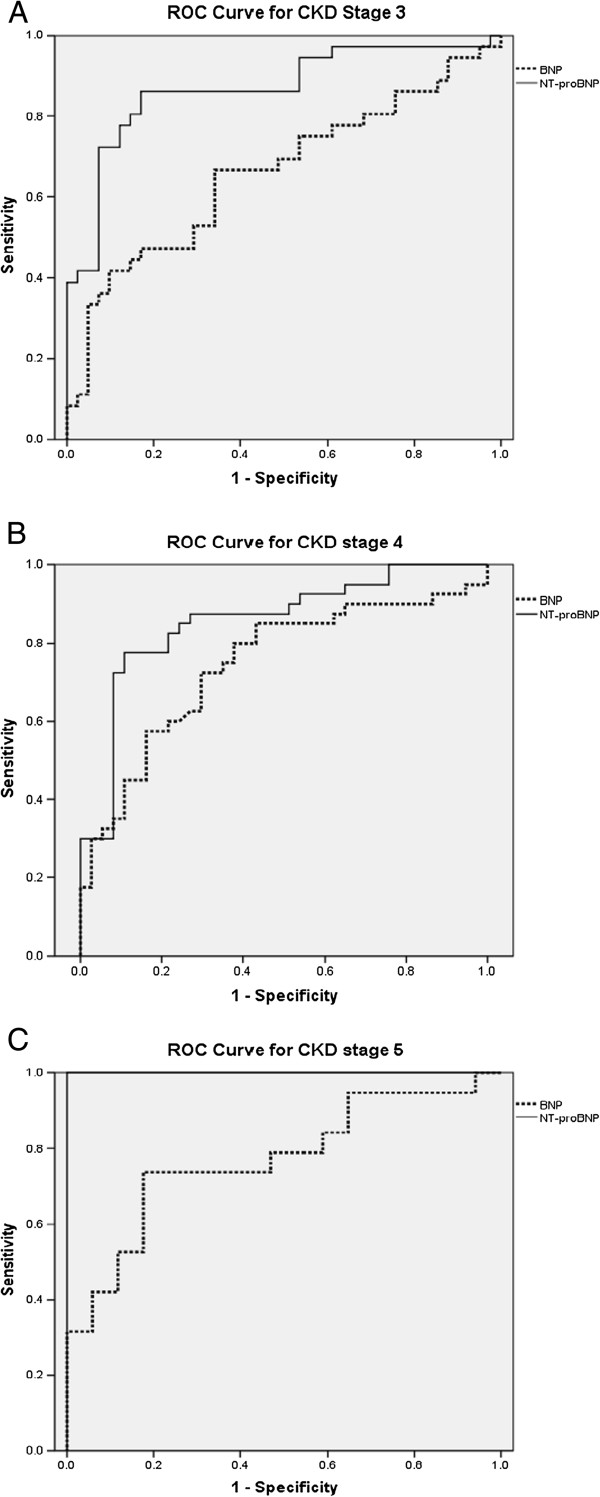
Receiver-operating characteristic (ROC) curves of BNP and NT-proBNP according to chronic kidney disease (CKD) staging. (A) For CKD stage 3 the area under the curve (AUC) for BNP and NT-proBNP was 0.66 and 0.88 respectively. (B) For CKD stage 4 the area under the curve (AUC) for BNP and NT-proBNP was 0.74 and 0.85 respectively. (C) For CKD stage 5 the area under the curve (AUC) for BNP and NT-proBNP was 0.77 and 1.00 respectively.